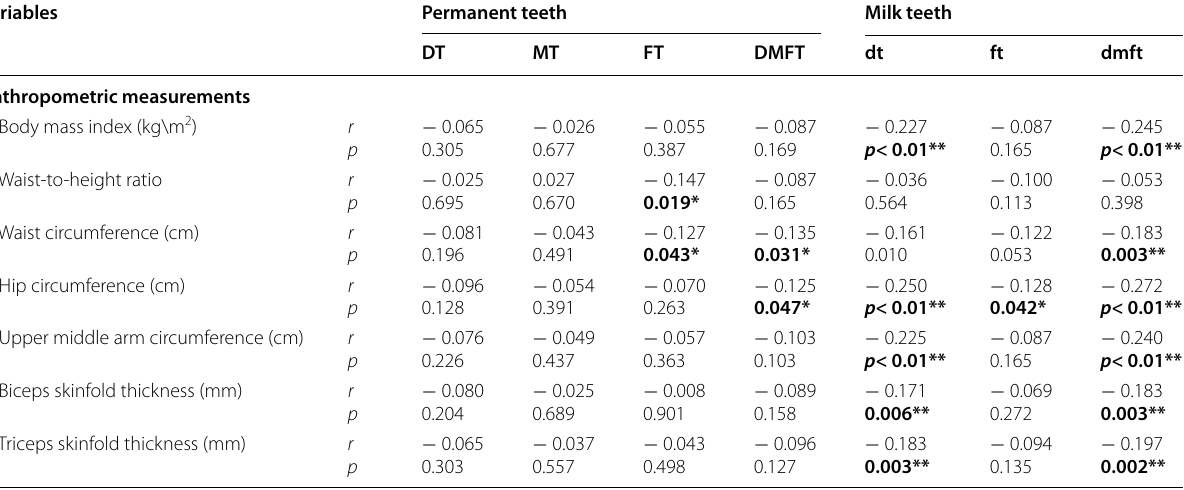
Table 5 Correlation between oral health indicators and children’s anthropometric measurements, socioeconomic status,